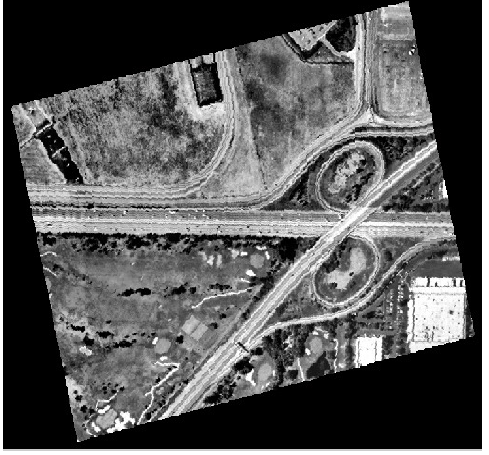
Figure22: Fig.17 with an Angle of Rotation +13 0